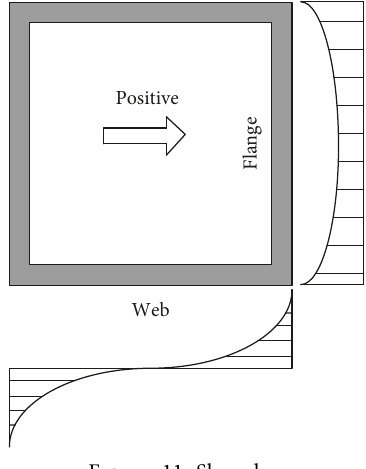
Figure 11: Shear